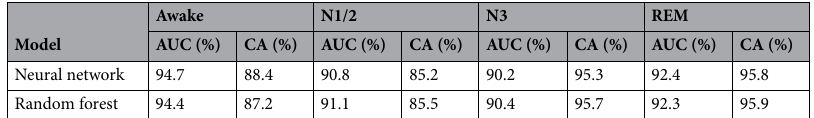
Table 2. Performance of both models (neural network and random forest) for individual sleep stages (awake, combined light NREM sleep (N1/2), N3 (SWS) and rapid eye movement sleep (REM)) in terms of area under the receiver operator curve (AUC) and classification accuracy (CA).